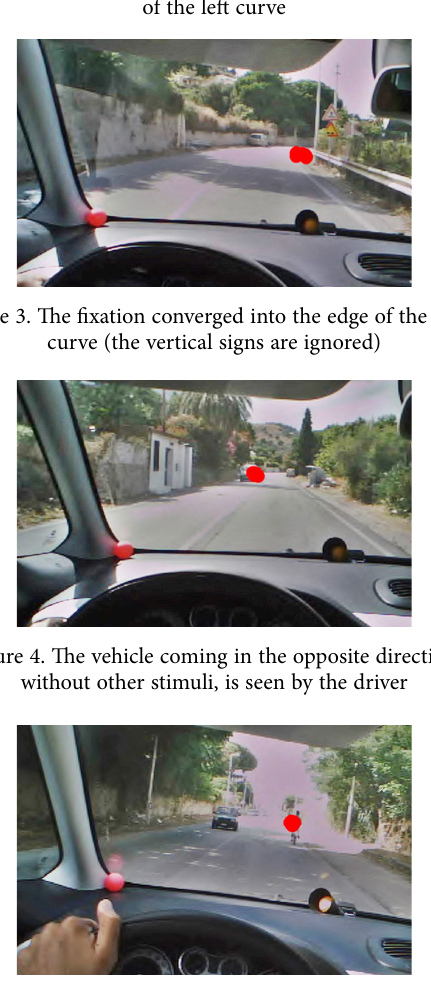
Figure 5. The driver’s eyes are on the bicycle in his same lane rather than on the car coming in the opposite direction, because the car is probably considered less